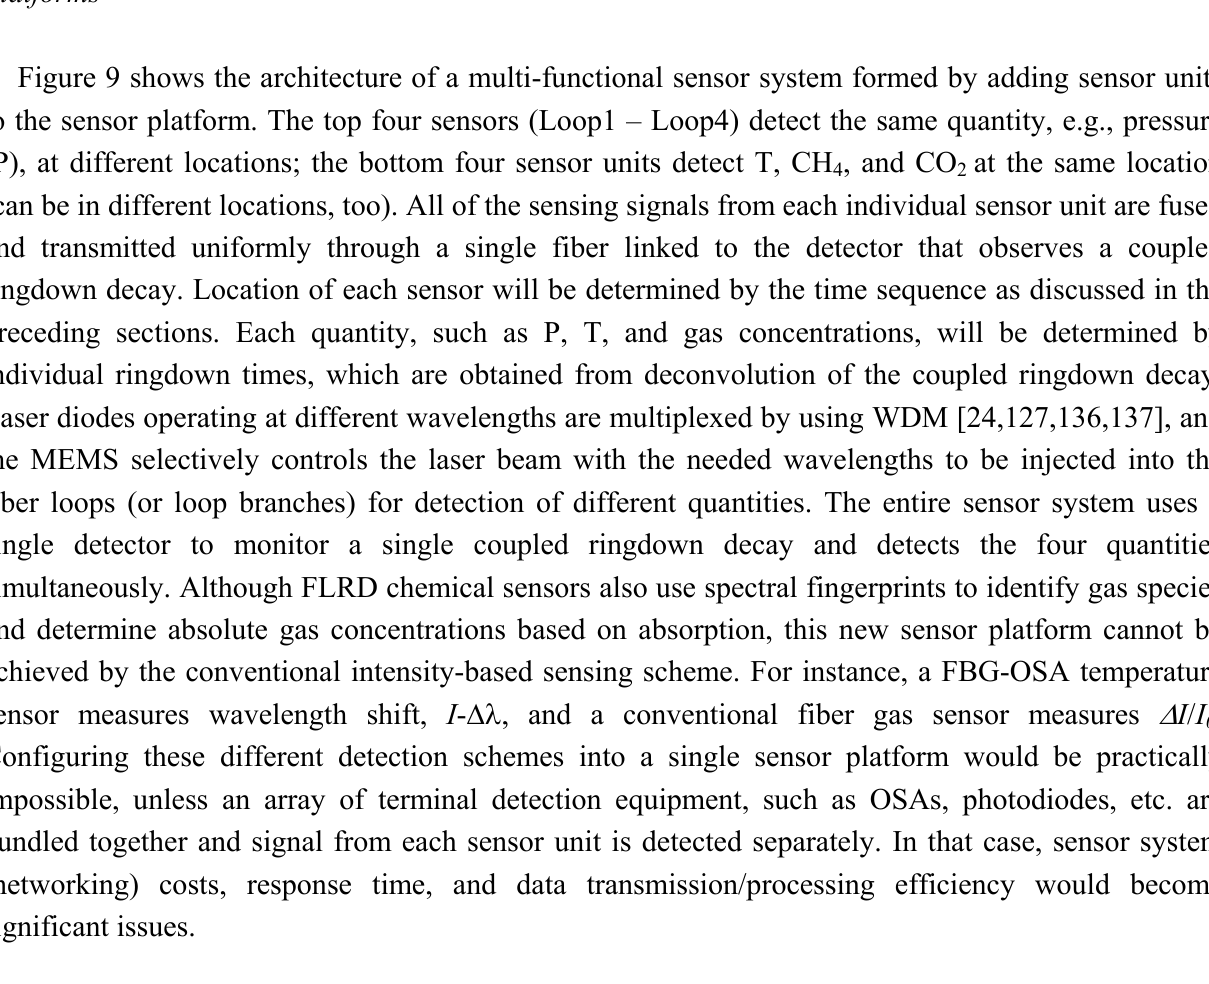
Figure 9. Proposed multi-functional fiber optic sensor system formed by adding FLRD sensor units to the sensor platform, which consists of a light source, a detector, and FLRD sensor